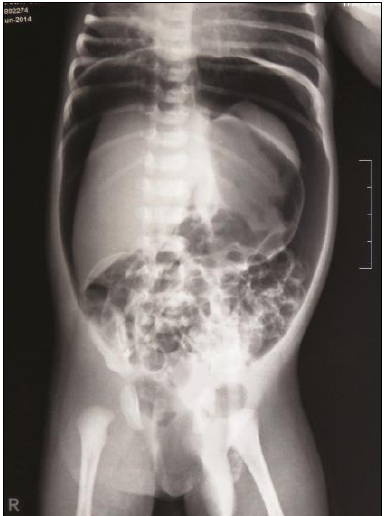
Figure 1: Gross pneumoperitoneum with air in the